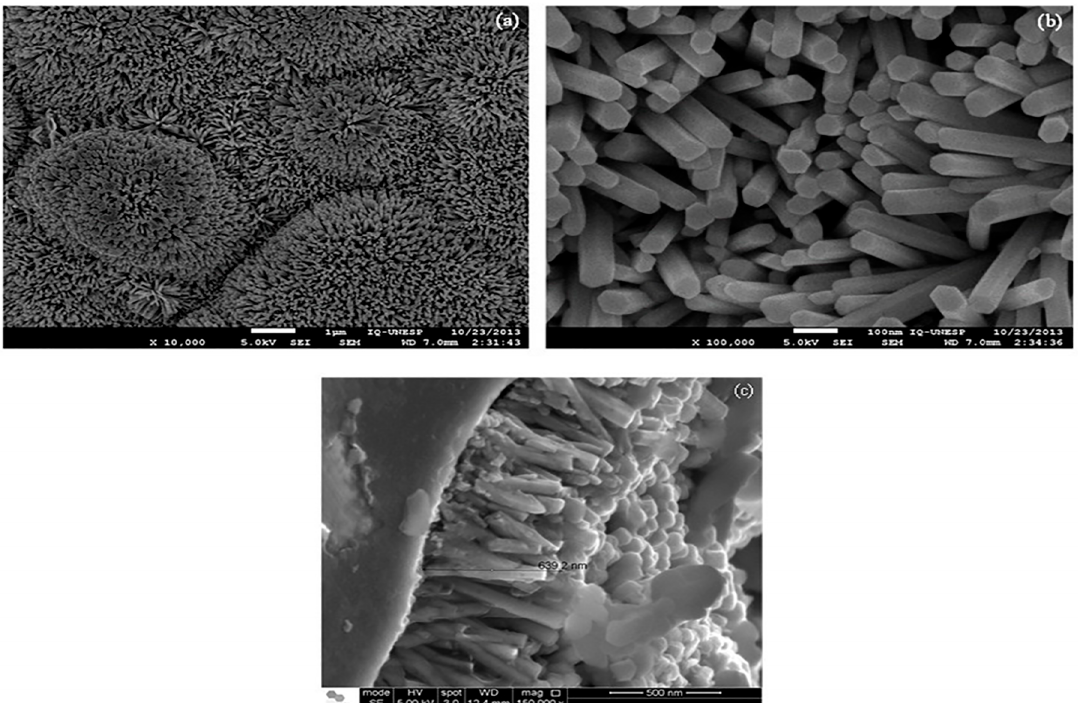
Figure 3. Scanning electron microscopy images: (a) and (b) as-prepared ZnO nanorods and (c) side view of the ZnO nanorods